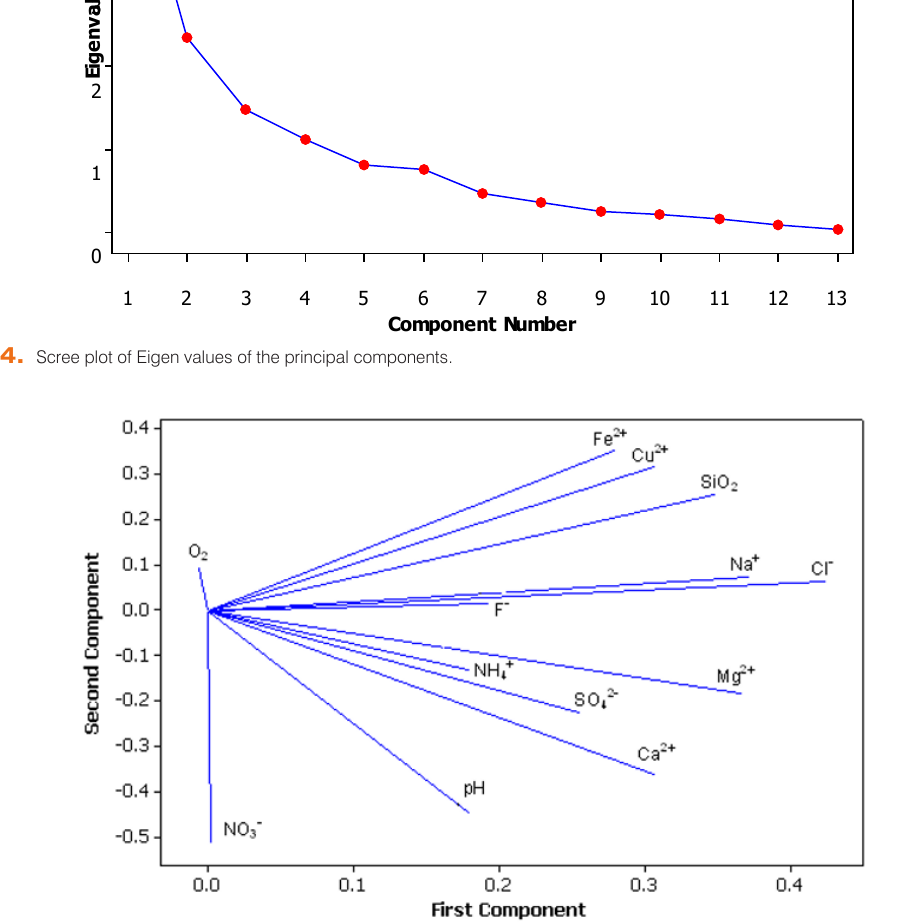
Figure 5. Loading plots of elements data in power plant water